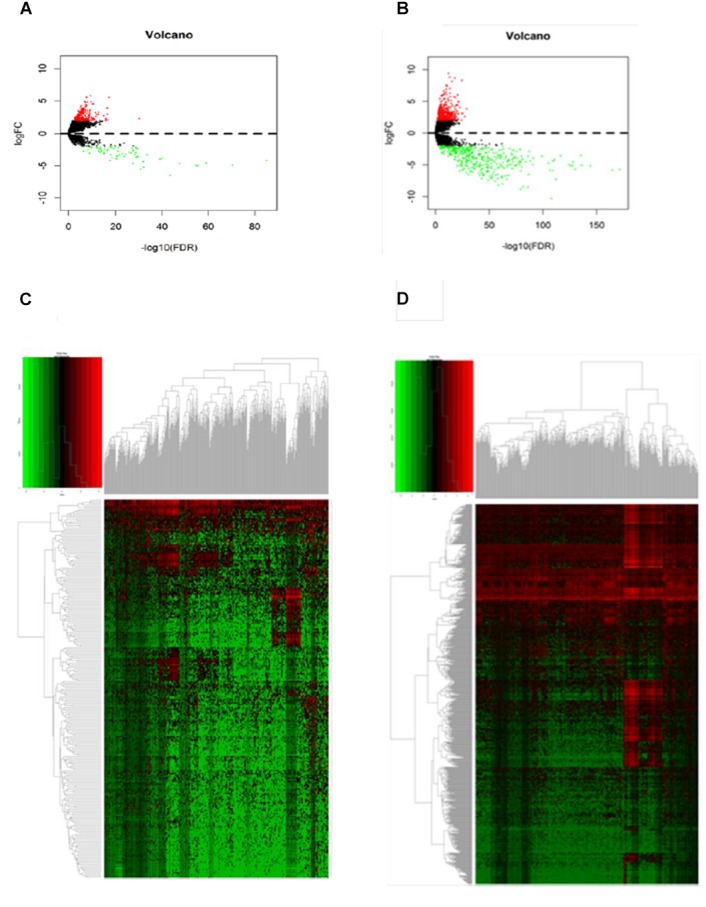
Differentially expressed genes between primary and metastatic melanoma (fold change > 2, FDR < 0.01). (A) Volcano plot of the FDR as a function of weighted fold change for DElncRNAs and (B) DEmRNAs, red dots represent significantly upregulated expressed genes and green dots represent significantly downregulated expressed genes (fold change > 2, FDR < 0.01). (C) Heat map for potential lncRNAs (n = 246) showed significant expression changes, in which 62 were downregulated and 184 were upregulated. Red through green color indicates high to low expression level. (D) Heat map for potential mRNAs showed significant expression changes (n = 856), in which 428 were downregulated and 428 were upregulated.